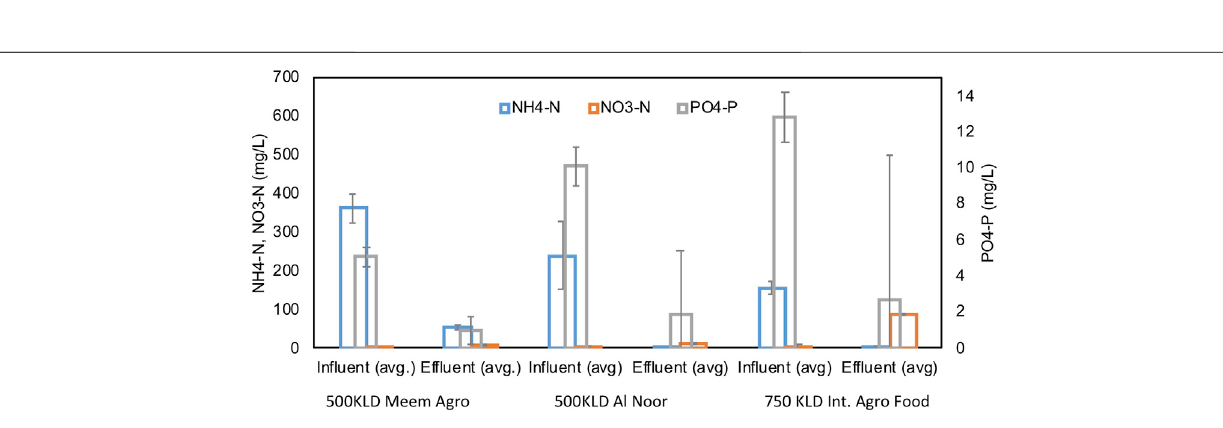
FIGURE 6 | NH 4 -N, NO 3 -N, and PO 4 -P in the ETPs of Meem Agro, Al Noor & Int. Agro Foods Pvt., Ltd.